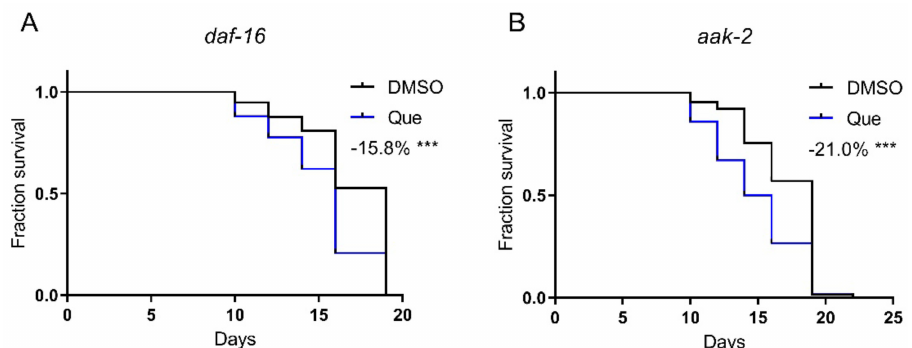
Figure 4. Quetiapine-induced lifespan shortening is independent of the AAK-2-DAF-16 pathway. Survival curves of mutant daf-16 ( n = 60 worms per group) ( A ) and aak-2 ( n = 60 worms per group) ( B ) treated with 100 µ M of quetiapine or DMSO at 20 ◦ C. Data were analyzed by using log-rank test (***: p <